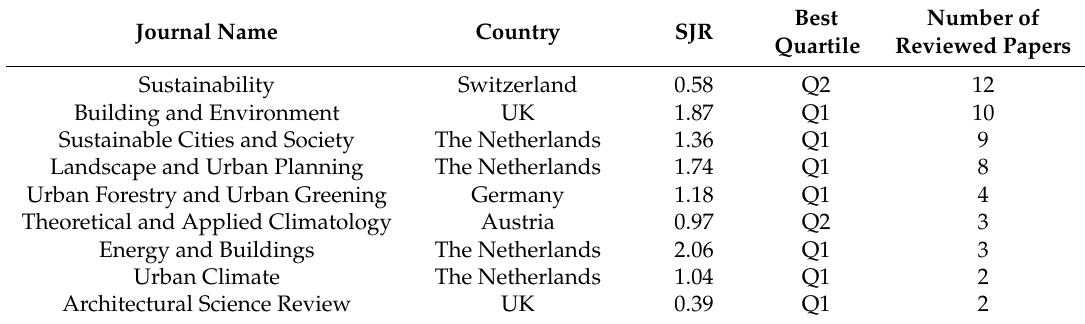
Table 1. Ranking of the main reviewed journals based on their Scimago Journal Rankings (SJR) (as per 2019 rankings) (scimagojr.com).